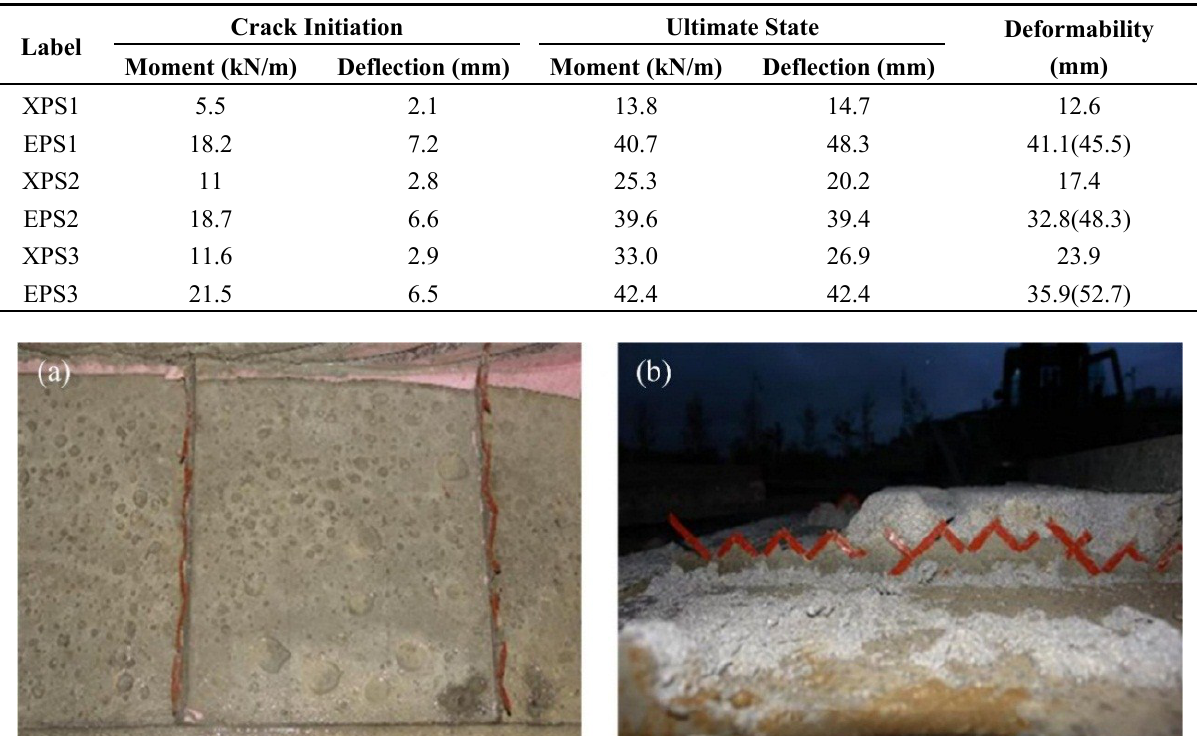
Figure 10. Bond failure surfaces of the concrete wythes: ( a ) XPS specimen; and ( b ) EPS